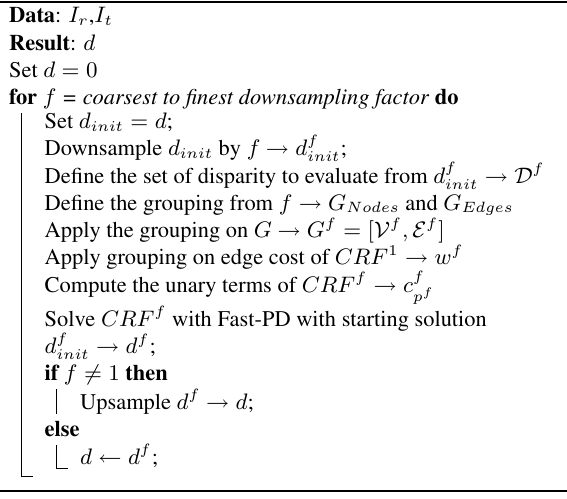
Algorithm 2: Energy pyramid, GM-EP algorithm